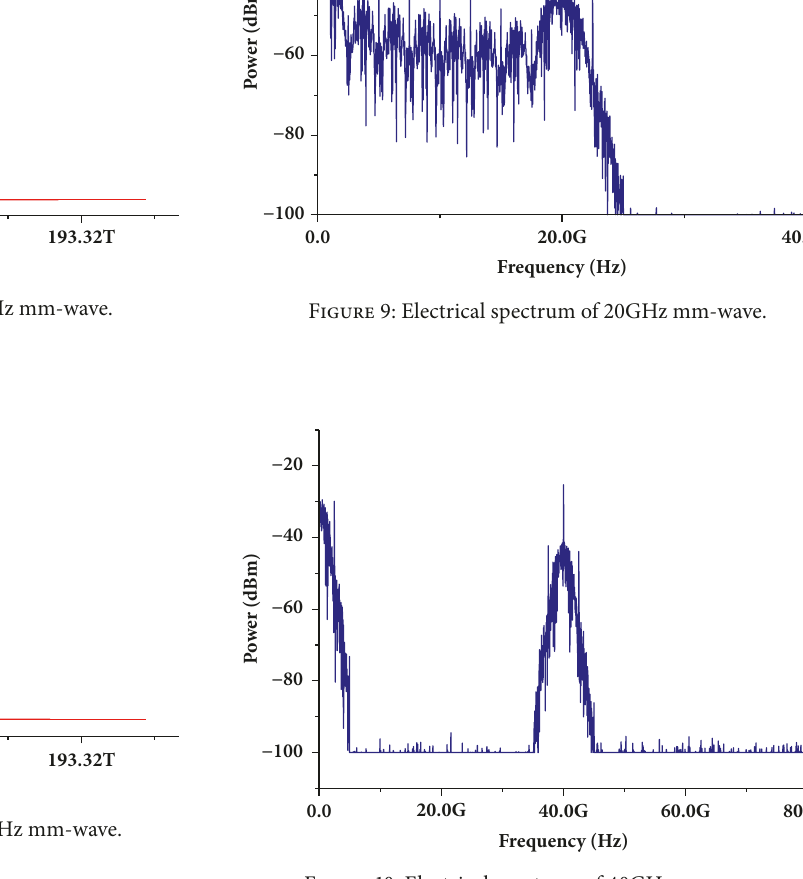
Figure 10: Electrical spectrum of 40GHz mm-wave.